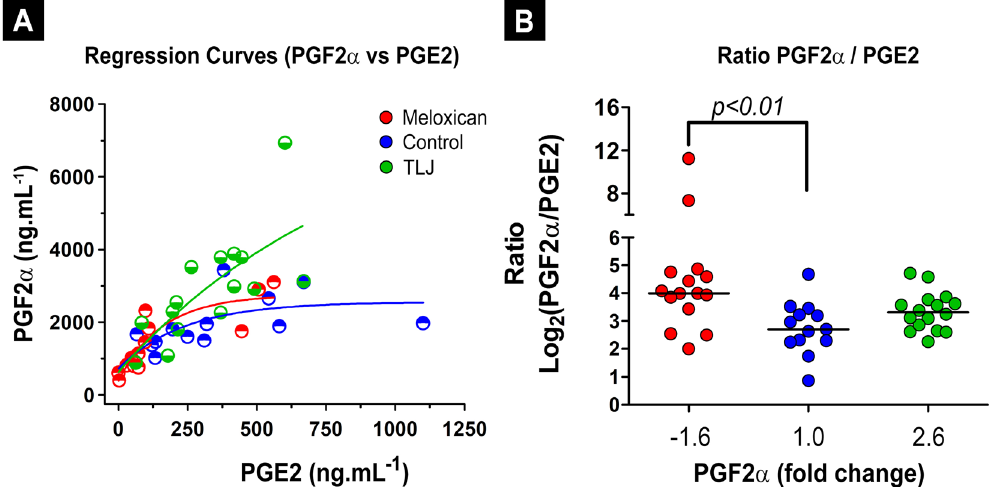
Figure 6. Demonstration of the augmentation of concentration of PGF2 α without alteration of PGE2 in the menstrual fluid of women that consumed TLJ at the beginning of the menstrual phase in contrast with those were treated with Meloxicam. ( A ) Best fitting curve (PGF2 α vs PGE2) drawn from PGs concentrations quantified from menstrual fluid collected on the second day after the beginning of the menstrual cycle, from the Control (n = 13), Meloxicam (n = 15) and TLJ (n = 16) volunteer groups. ( B ) Scatter graphic showing the individual values and medians of the ratio (PGF2 α /PGE2) in relation to change fold of PGF2 α of the Control, Meloxicam and TLJ groups. The medians were compared using the Kruskal-Wallis and Dunn´s statistical tests for multiple